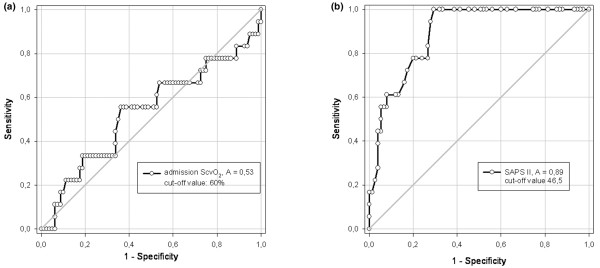
Receiver operator characteristic (ROC) analysis of central venous oxygen saturation (ScvO2) and Simplified Acute Physiology Score (SAPS II). Outcome parameter for ROC curves of (a) ScvO2 and (b) SAPS II was 28-day mortality. Area under the curve (A) values were 0.53 for ScvO2 and 0.89 for SAPS II.